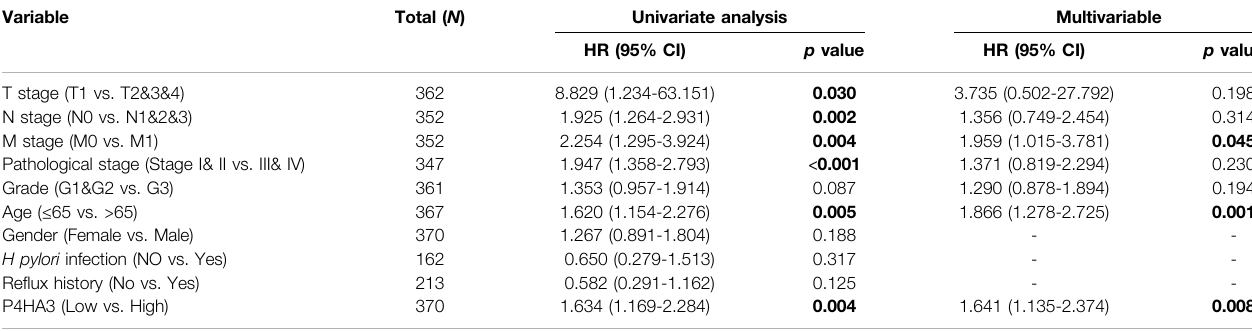
TABLE 3 | Univariate and multivariate Cox regression analysis of the P4HA3 expression and overall survival in gastric cancer patients.